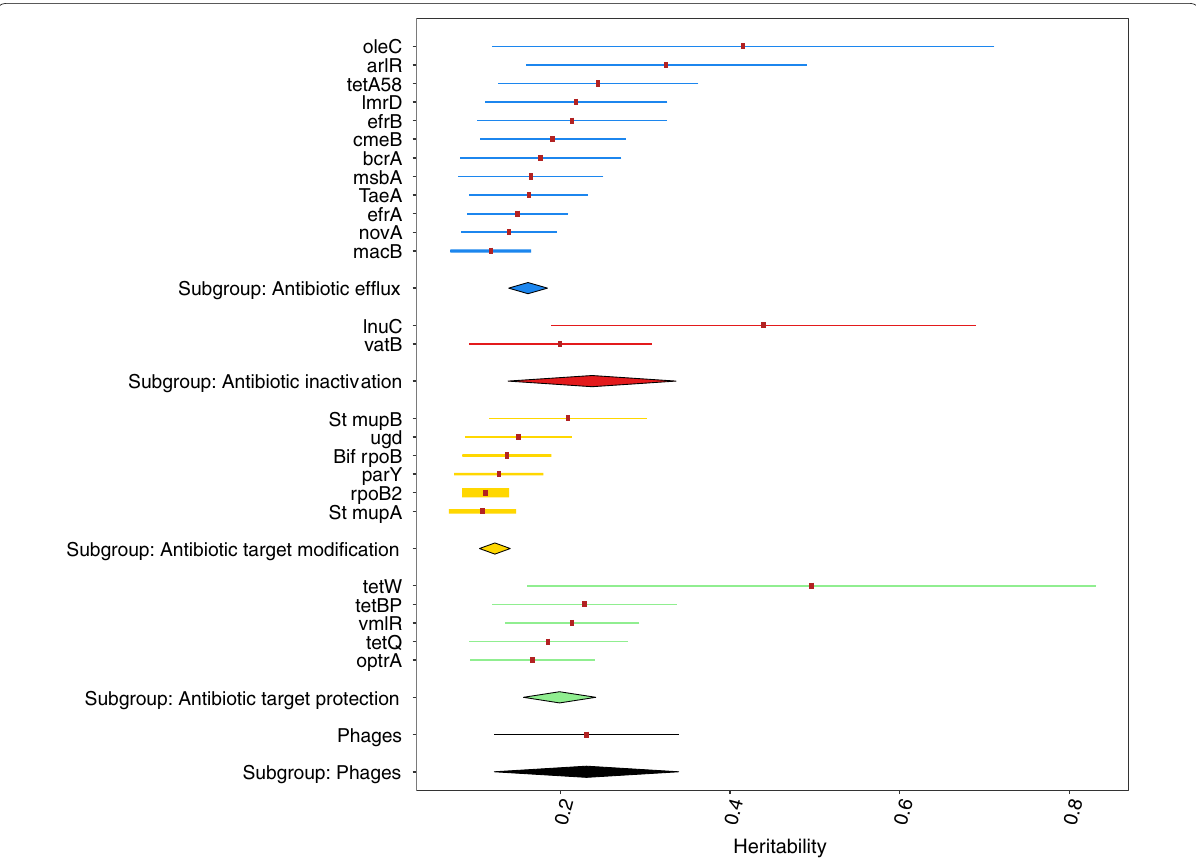
Fig. 5 Heritability estimates for the relative abundance (RA) of the 25 most prevalent ARGs (by action mechanism) and the RA of total bacteriophages. The heritability values are represented by the red points and the HPD95 by the lines around them. The diamond represents the pooled result of that